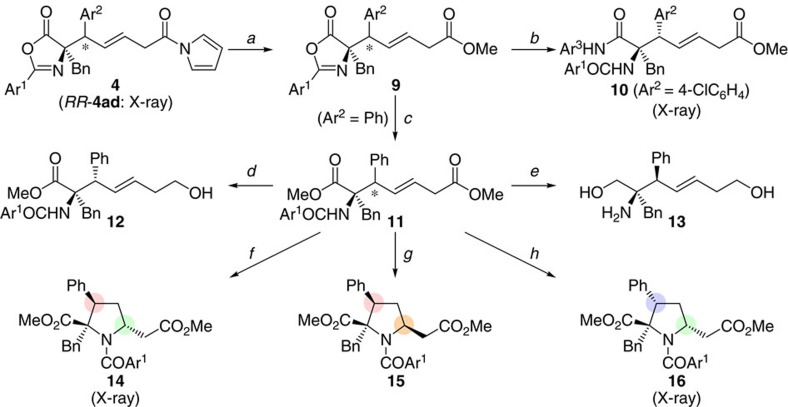
Conversion to various α-tetrasubstituted α-amino acid derivatives.Conditions (Ar1=2,6-(MeO)2C6H3): (a) NaOMe, MeOH/CH2Cl2, 0 °C, 81% (from RS-4ac); 91% (from RR-4aa); 83% (from RS-4aa), (b) BF3·OEt2, 4-ClC6H4NH2 (Ar3NH2), toluene, 100 °C, 56% (from RS-9ac), (c) SOCl2, MeOH, 5 °C, 83% (from RR-9aa); 69% (from RS-9aa), (d) LiBH4, THF, rt, 95% (from RS-11), (e) (i) LiAlH4, Et2O, reflux, (ii) KOH, aqueous MeOH, 150 °C (MW), 78% (2 steps from RR-11), (f) PtCl2, Cs2CO3, DMF, 140 °C, 76% (pure diastereomer, see Supplementary Fig. 103) (from RR-11), (g) DBU, MeOH, 40 °C, 54% (pure diastereomer) (from RR-11), (h) DBU, MeOH, 60 °C, 88% (diastereomeric mixture, dr=14:1, see Supplementary Fig. 104 for the absolute stereochemistry of major isomer) (from RS-11).